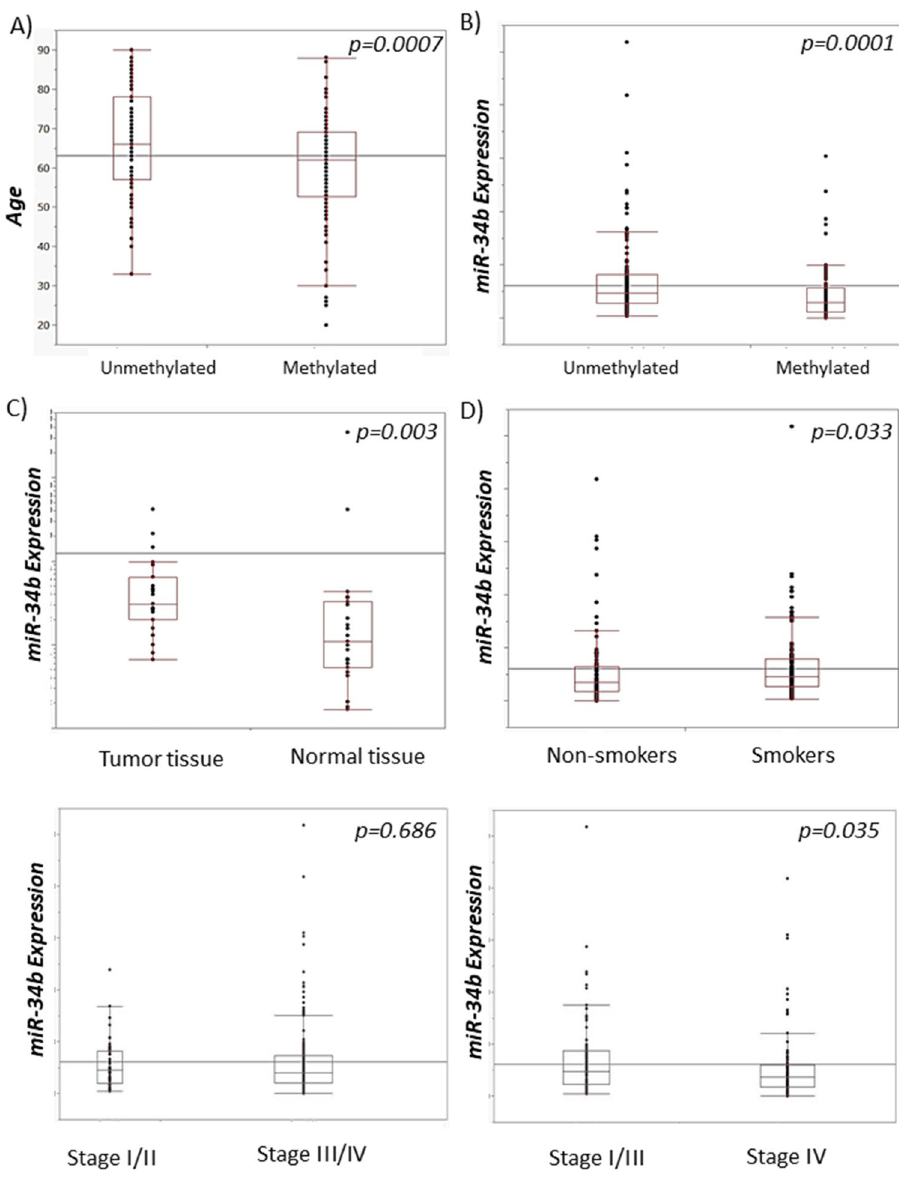
(log scale): tumor vs normal tissue ( D ) miR-34b expression and smoking status ( E ) miR-34b expression in stage III/IV compared to stage I/II tumors ( F ) miR-34b expression in stage IV compared to stage I–III